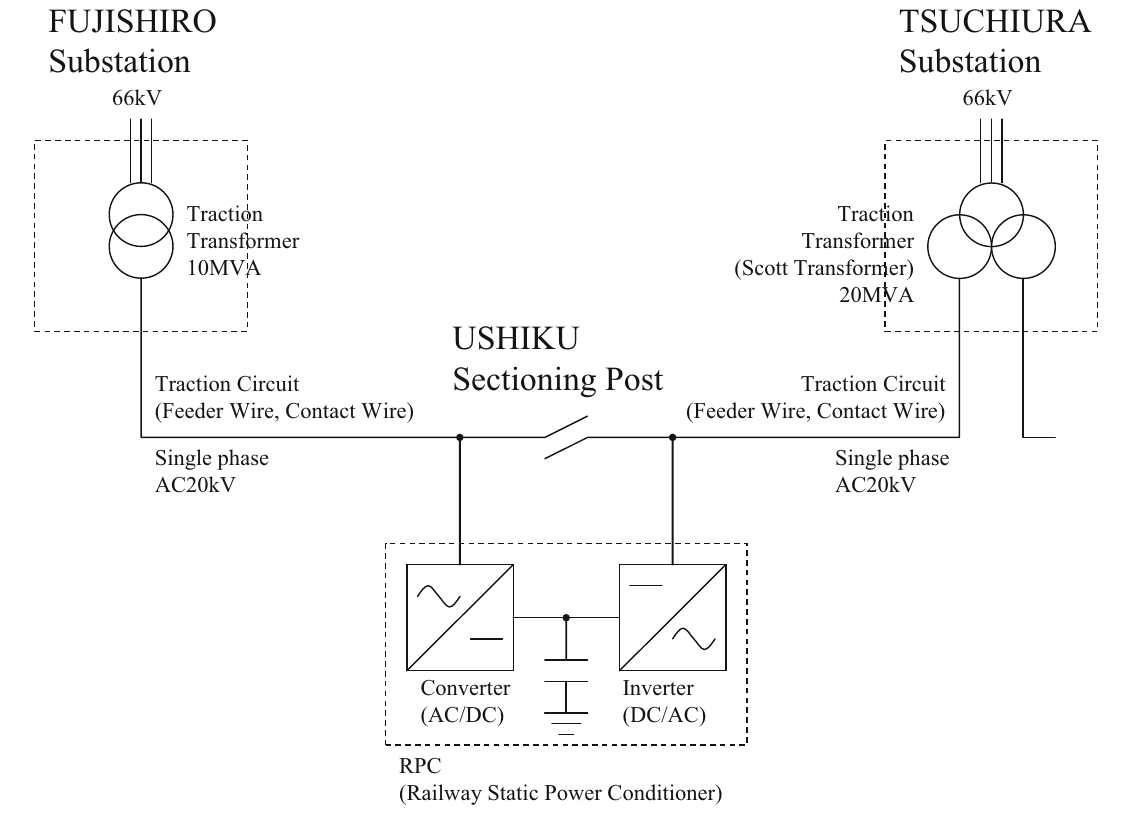
Fig. 13 Circuit configuration around RPC at Ushiku